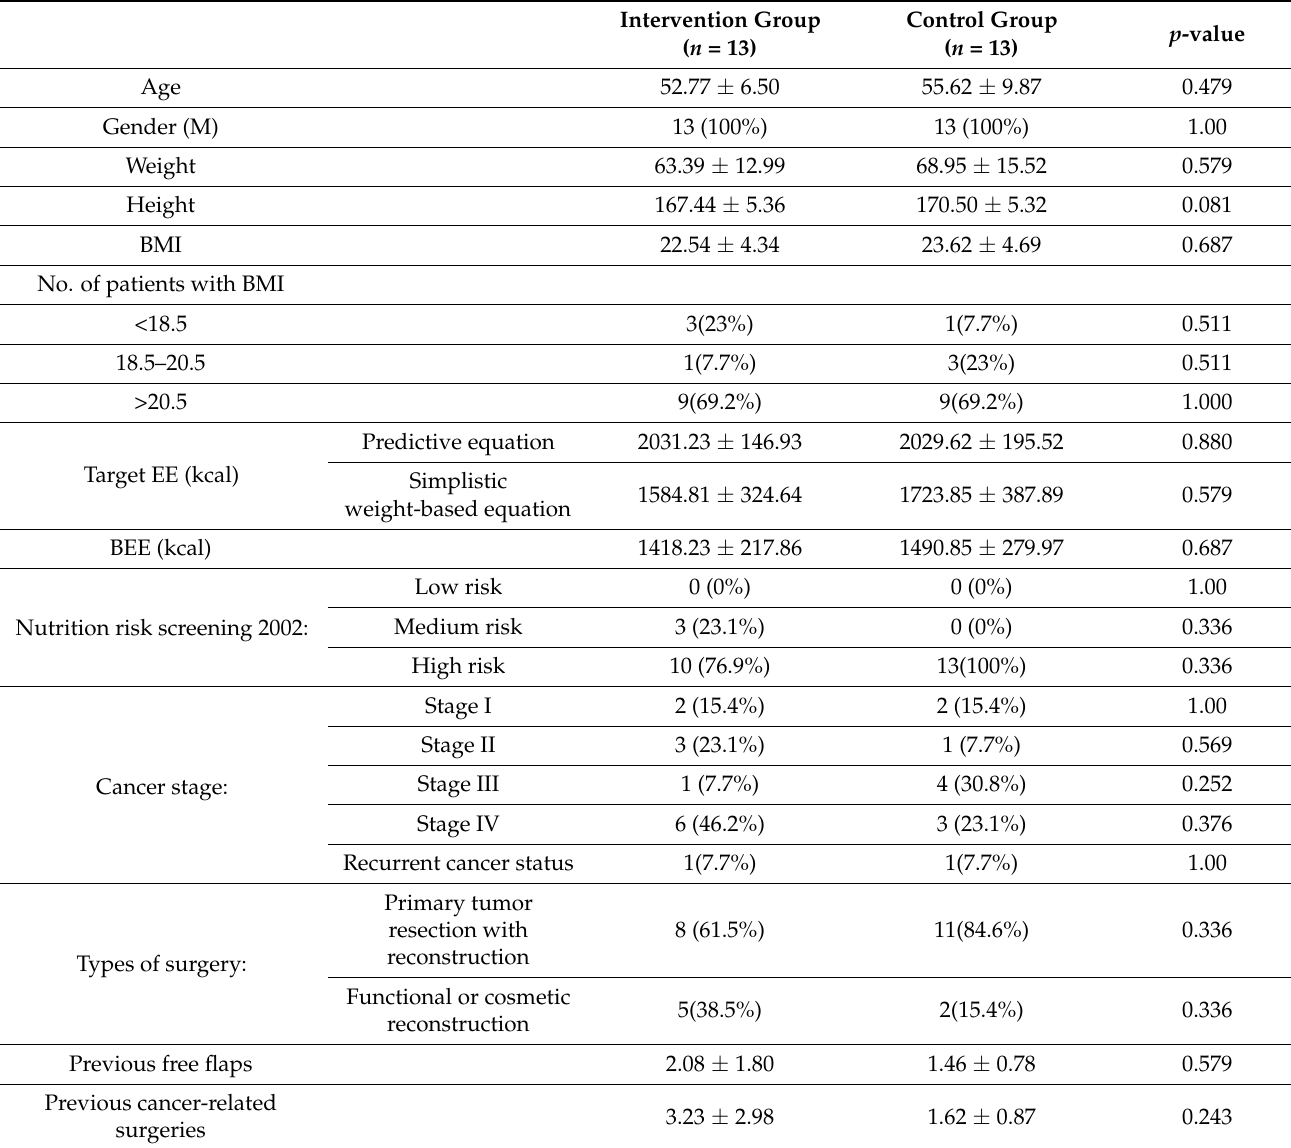
Table 1. Baseline characteristics.